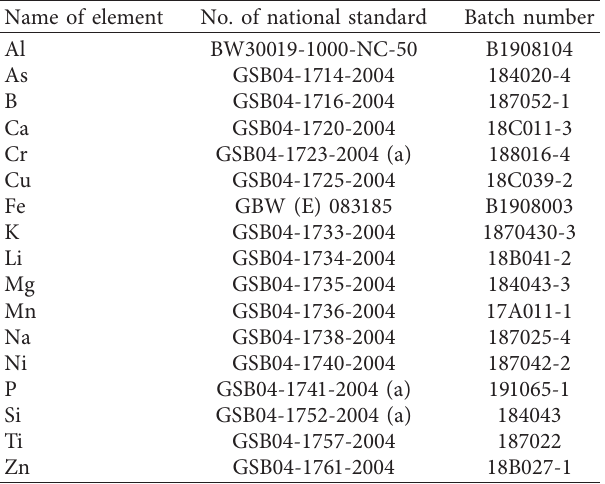
Table 2: Information of single element standard solution. Name of element